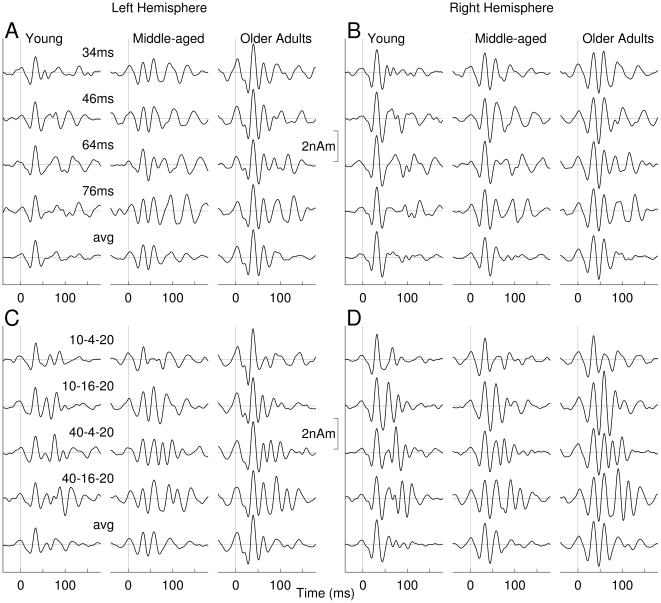
Waveforms of transient gamma band responses for the three age groups, eight stimulus types and left and right hemispheres.(Time zero refers to the stimulus onset.) A: Responses to no-gap stimuli as observed in the left hemisphere. The bottom trace shows the response waveform averaged across the four stimuli with different duration. B: Right hemispheric responses to no-gap stimuli. C–D: Responses to gap-stimuli accordingly.